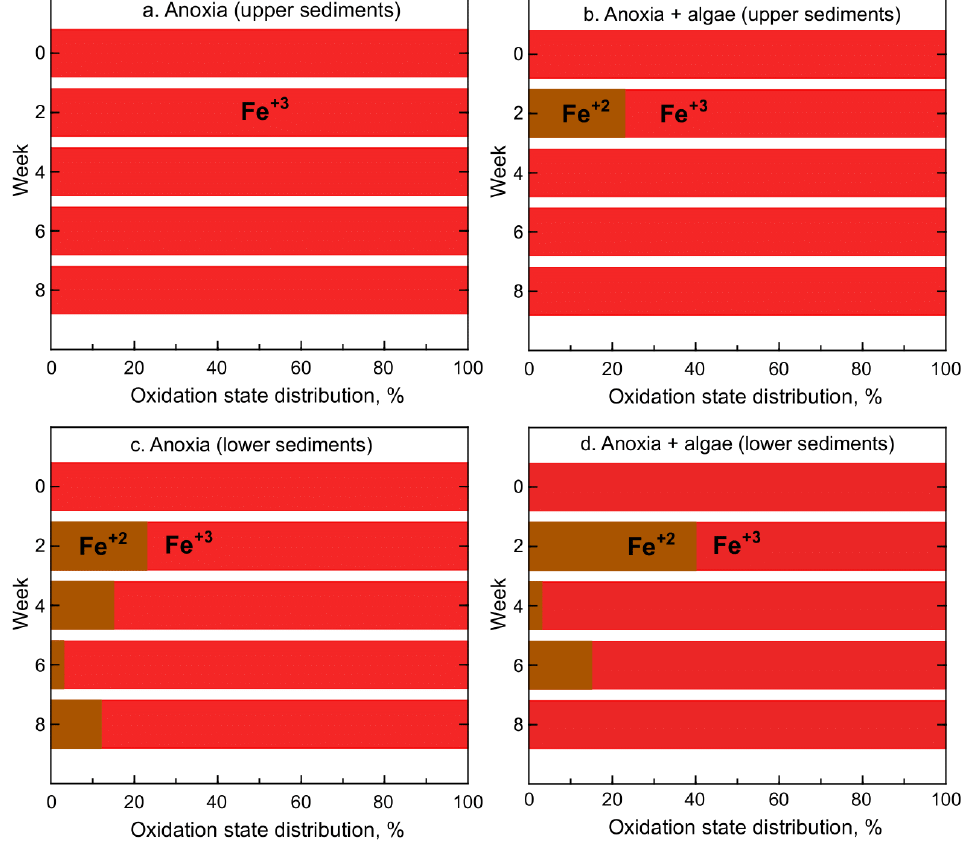
Figure 5. Distribution of iron oxidation states in upper and lower sediment samples of the control (anoxia) and treatment (anoxia + algae) cores over the course of the 8-week experiment.